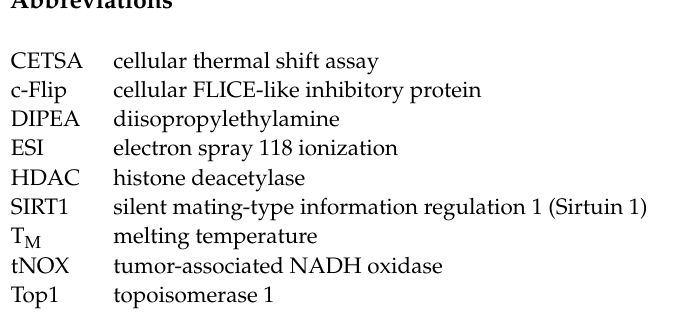
blots and molecular weight markers in Figure 3; Figure S3: The uncropped blots and molecular weight markers in Figure 4; Figure S4: The uncropped blots and molecular weight markers in Figure